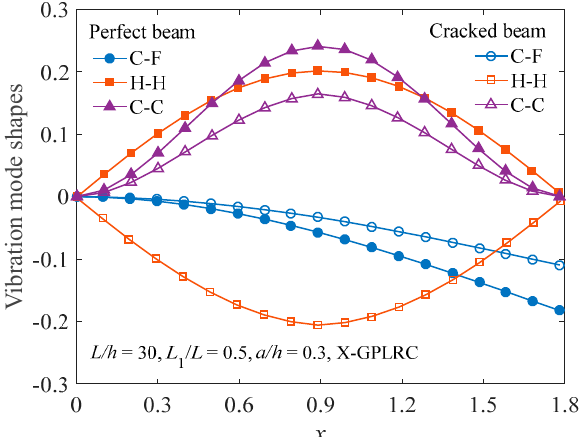
Figure 3. Fundamental vibration mode shapes of intact and cracked FG-X-GPLRC beams. Table 3. Dimensionless fundamental frequencies ω 1 / ω 10 of cracked C-C FG-GPLRC beams. ( L / h =